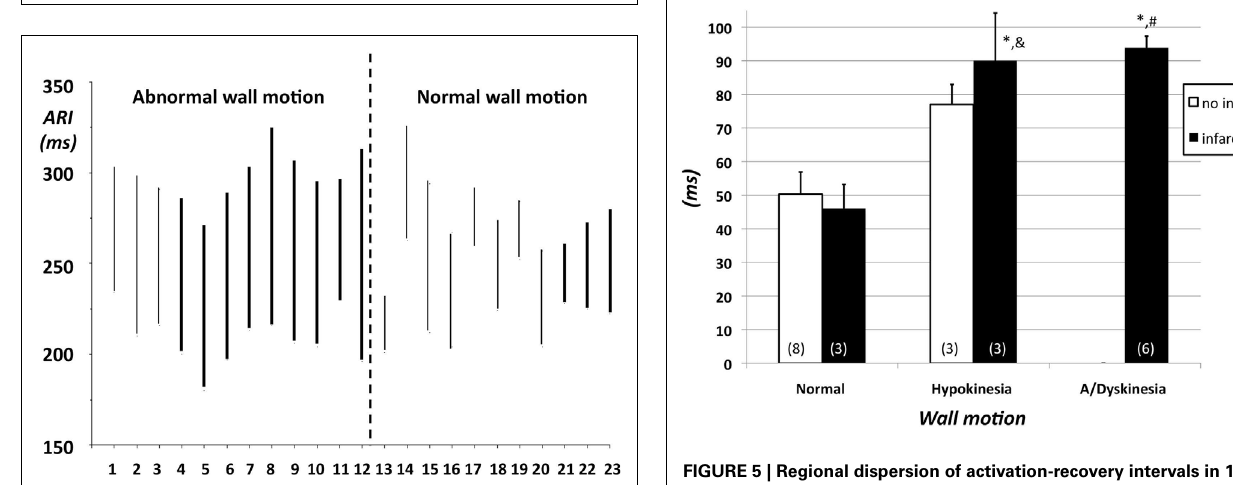
FIGURE 2 | Local electrograms at the nine positions in one of the patients. The first vertical line indicates the stimulus artifact.The number below each of the nine positions is the local activation-recovery-interval (ARI), measured from dV/dt min of the QRS till dV/dt max of theT wave (see Materials and Methods).